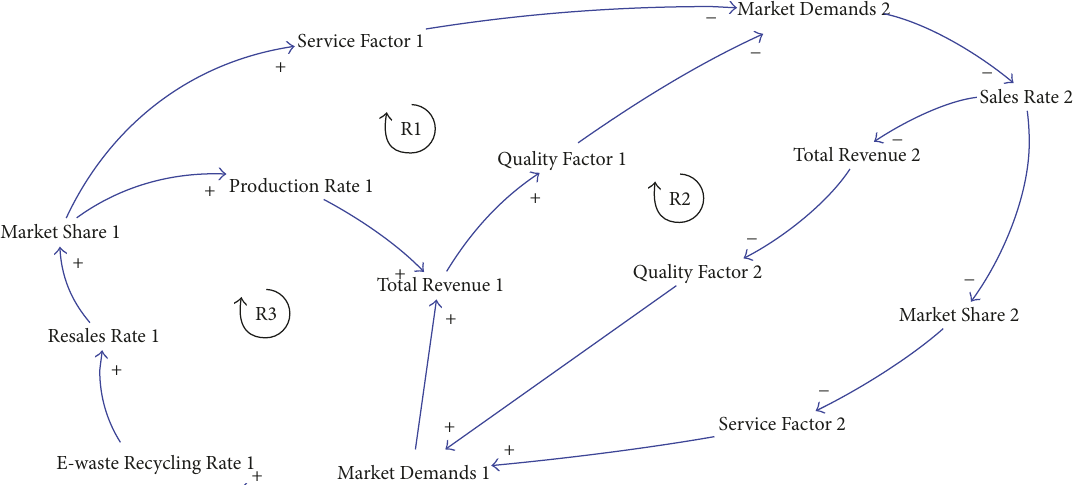
Figure 2: Casual loop diagram of across-chain